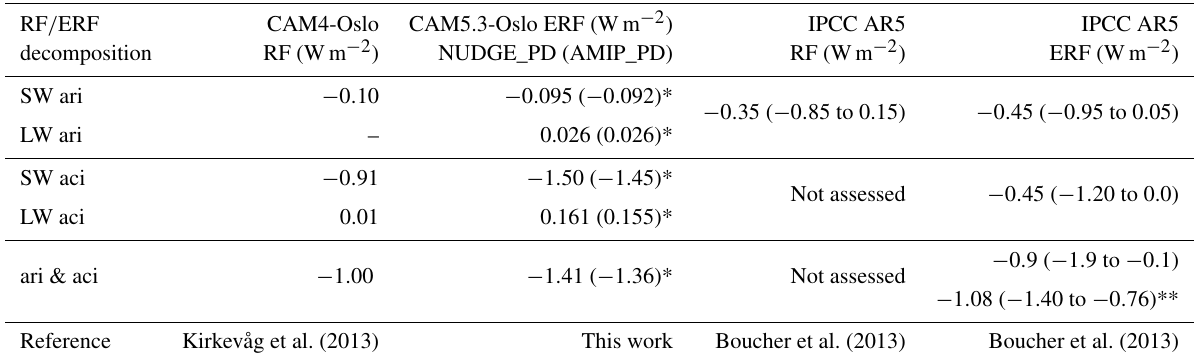
Table 10. Globally and annually averaged aerosol radiative forcing (RF) and effective radiative forcing (ERF) decomposed into its SW and LW components for CAM5.3-Oslo and CAM4-Oslo compared with the respective mean values and ranges reported in IPCC AR5. Note that the estimates from IPCC AR5 are only available as sums of the SW and LW contributions and have been estimated for the period 1750 to 2011 (with one exception, see the footnote), whereas the CAM4-Oslo and CAM5.3-Oslo estimates are for year 1850 to